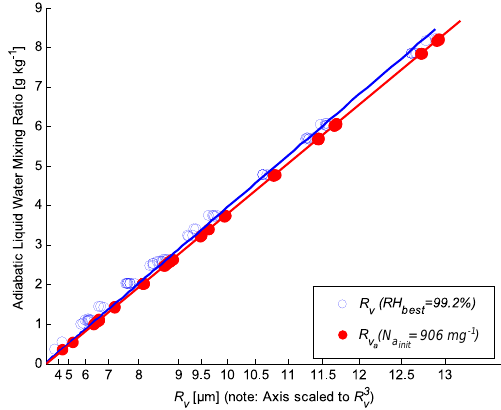
Fig. 4. R v (blue circles) and R v (red circles) vs. the adiabatic liquid a water mixing ratio (LWC a ). The red data points denote the calcu- lated R v based on the inferred LWC a profile of flight 20090825 a over central India, and N a (=906mg − 1 ) that was derived by init Eq. (1) for the data points with AF > 0.25 (Fig. 2). The blue data points show the theoretical values of R v based on the actual 1Hz AF data ( > 0.25) and N a , assuming homogeneous mixing with init entrained air whose RH best is the mean of the RH best values in Fig. 3a. The ratio of the slopes of the blue and red linear best fits ap- proximates the effect of the homogeneous vs. inhomogeneous mix- ing assumptions on N a , and is therefore used as a first correction for N a init